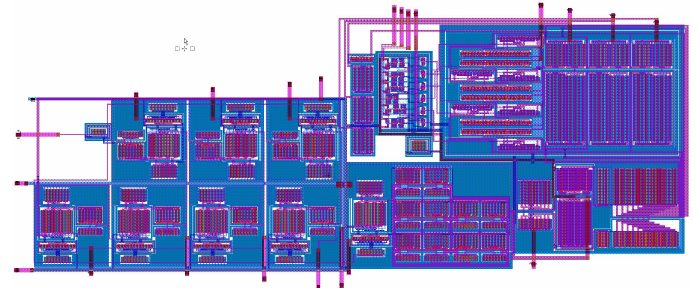
Figure 19. Multi-scroll chaotic oscillator